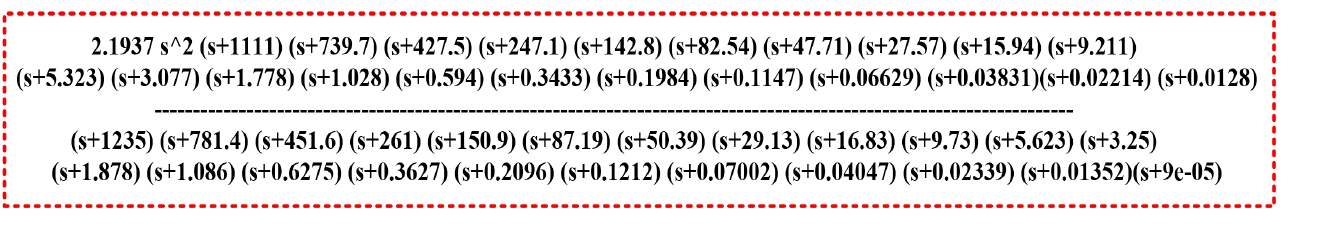
Figure A2. Transfer functions continuous and integer expression of s 1.1 .